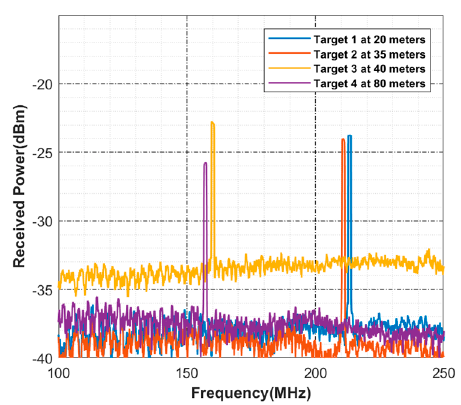
Figure 5. Range resolution.